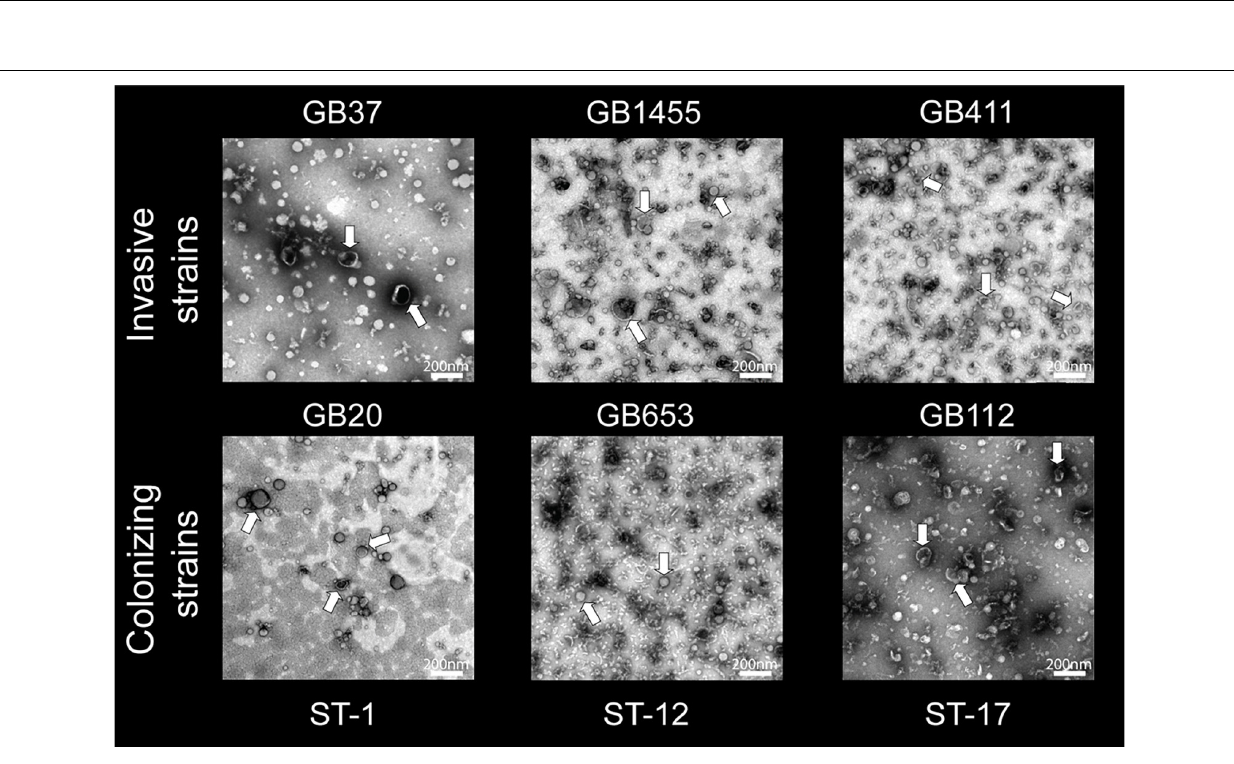
Frontiers in Microbiology |